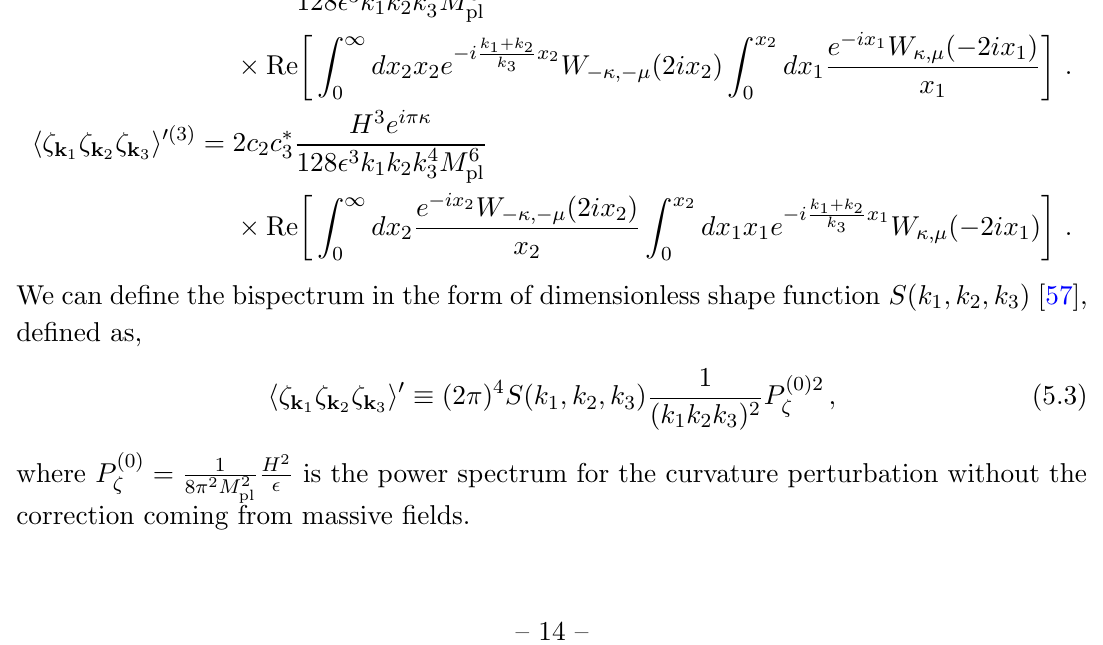
Figure 7 . The Feynman diagram of the bispectrum that involves the interaction of (cid:14)(cid:27) with the in(cid:13)aton. For the total contribution, we need to include the correction from (cid:14)(cid:27) (cid:3) . (cid:3) h (cid:16) i 0 (2) = 2 c 2 c k 1 (cid:16) k 2 (cid:16) k 3